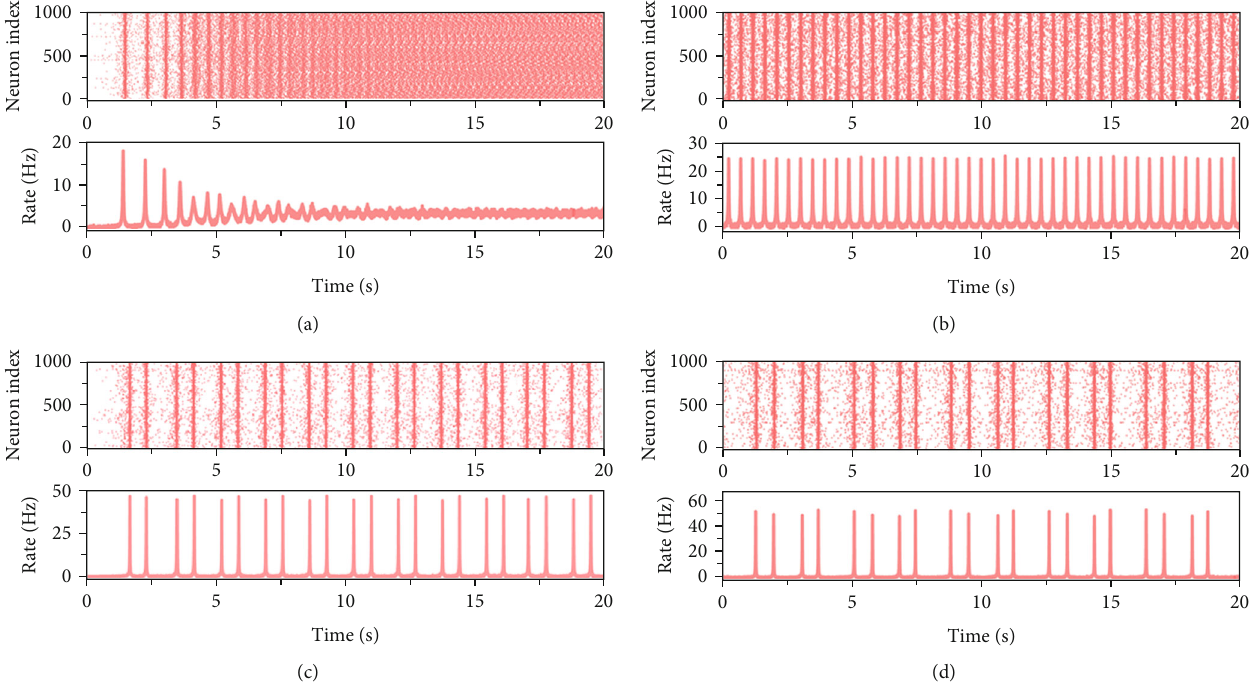
Figure 4: Activities of the network model when ð I (d). In each chart, the upper panel is the raster plot of 1000 randomly selected neurons in the excitatory population, the bottom panel gives the corresponding fi ring rate of the excitatory population.